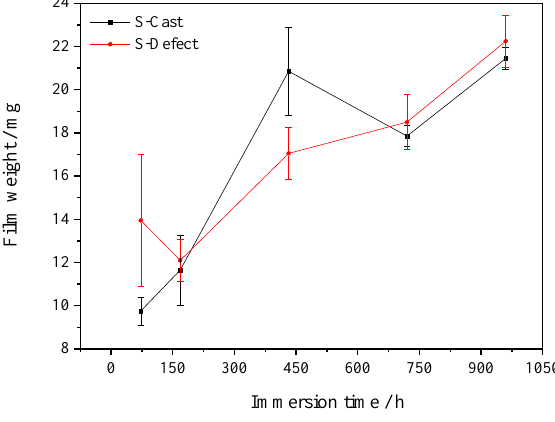
Figure 2. Film weight of S-Cast and S-Defect immersed for di ff erent time periods in artificial seawater.